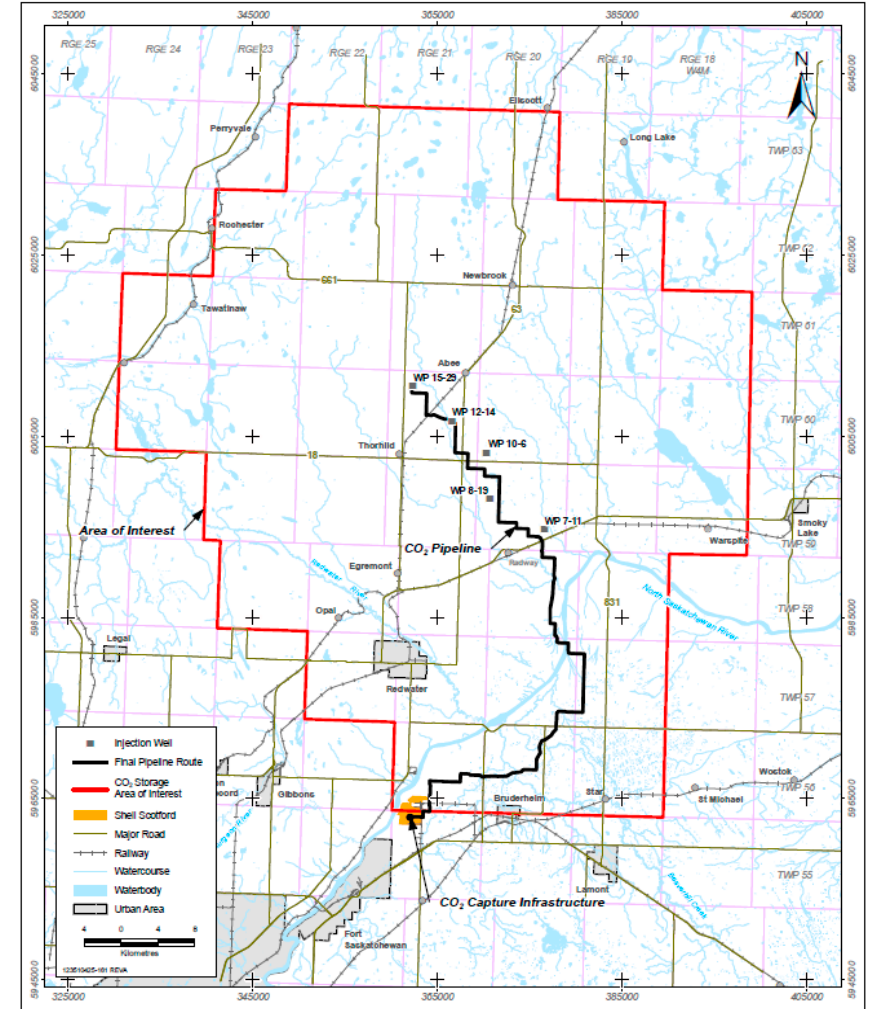
Figure 13. Quest project area of interest (source: [50]).